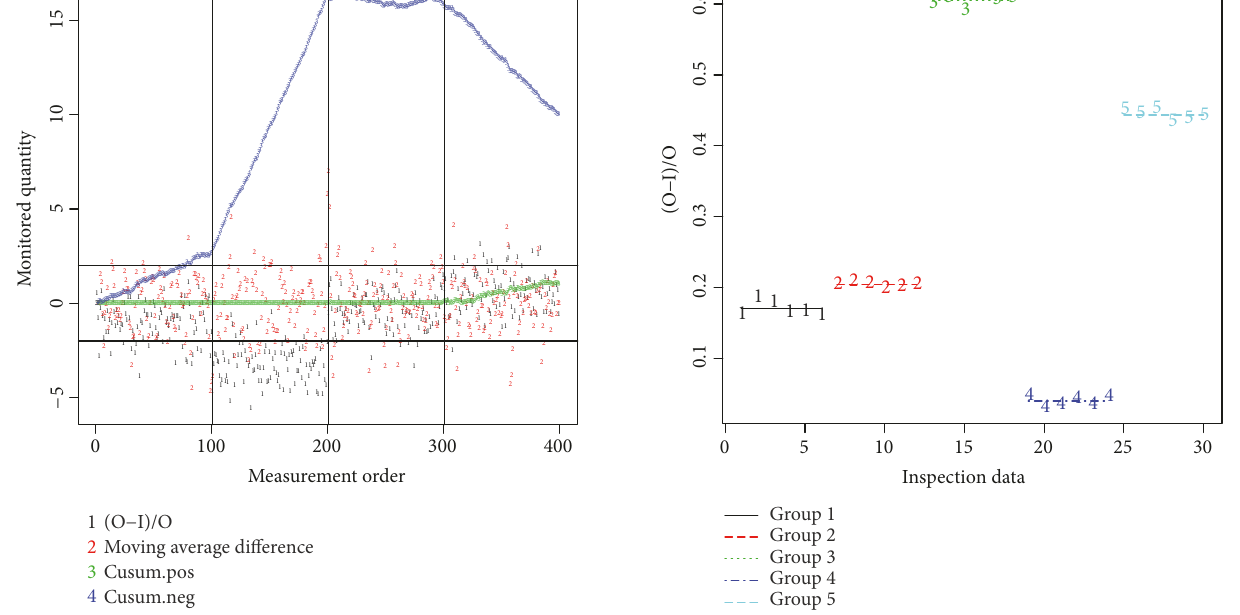
Figure 5: Even with 𝛿 𝑅 = 0.01,𝛿 𝑆 = 0.3 so 𝛿 𝑆 /𝛿 𝑅 = 30 , some group changes will not necessarily be detected (such as the change from group 1 to group